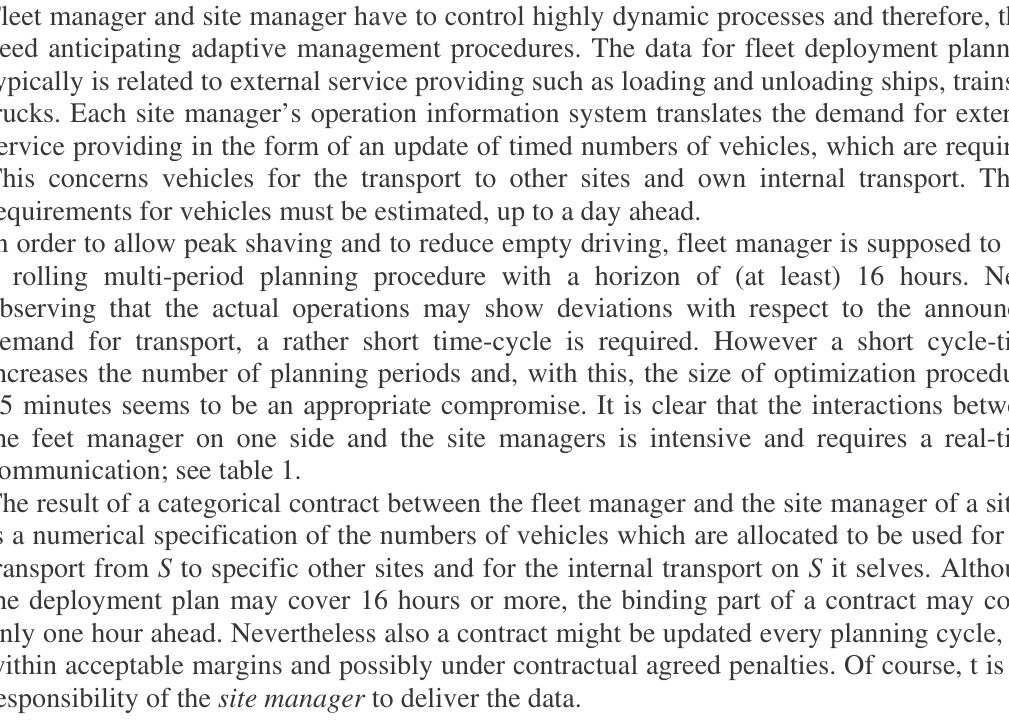
Table 1. Interaction between the Fleet Manager and the generic Site Manger Actions of Site Manager